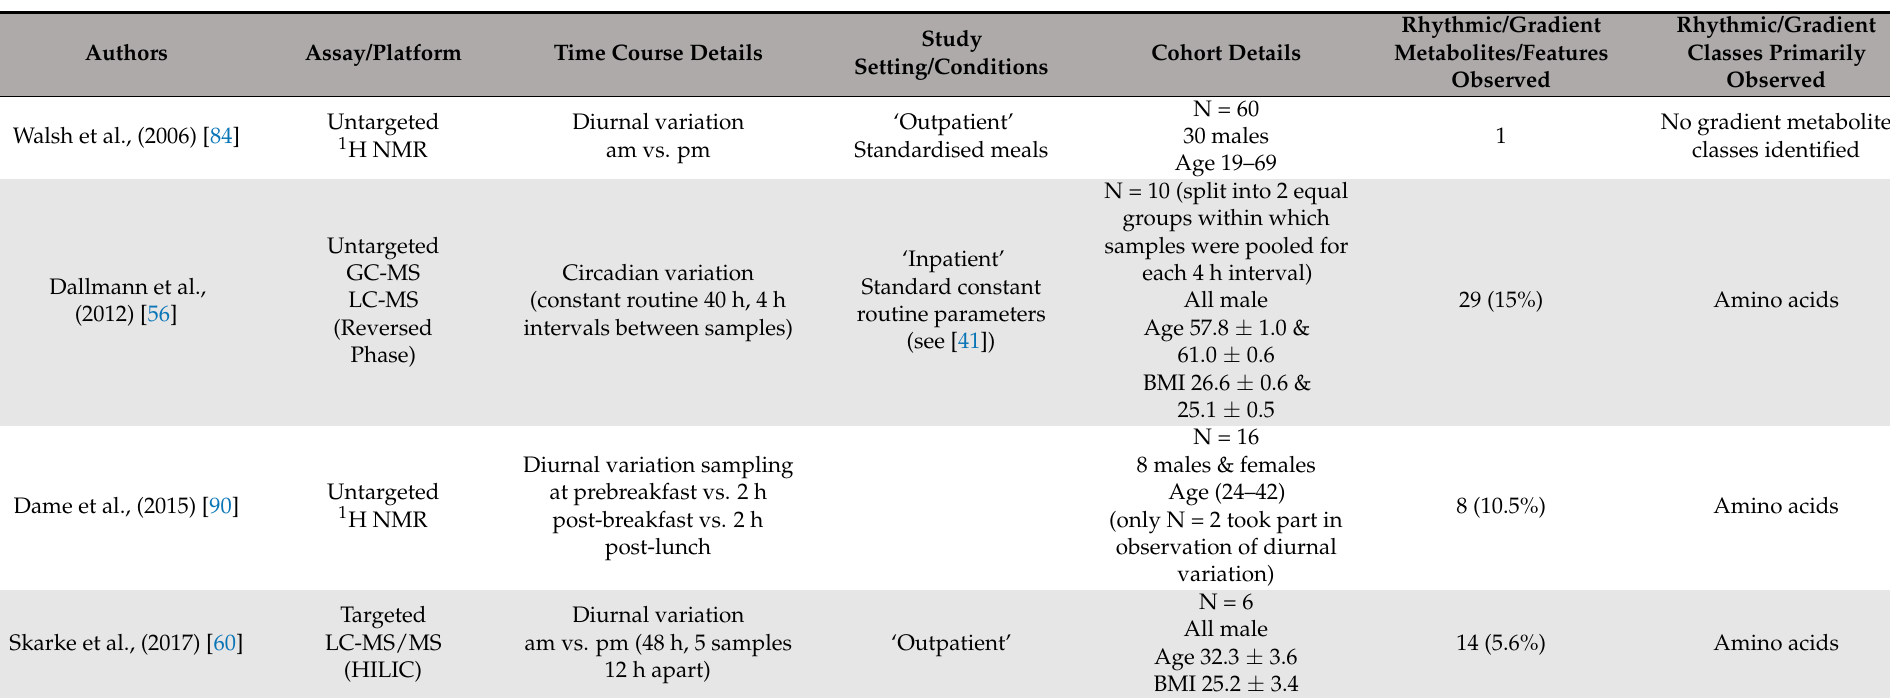
Table 4. A brief summary of study design, cohort details and results with regard to observed time of day variation of metabolites for relevant studies analysing